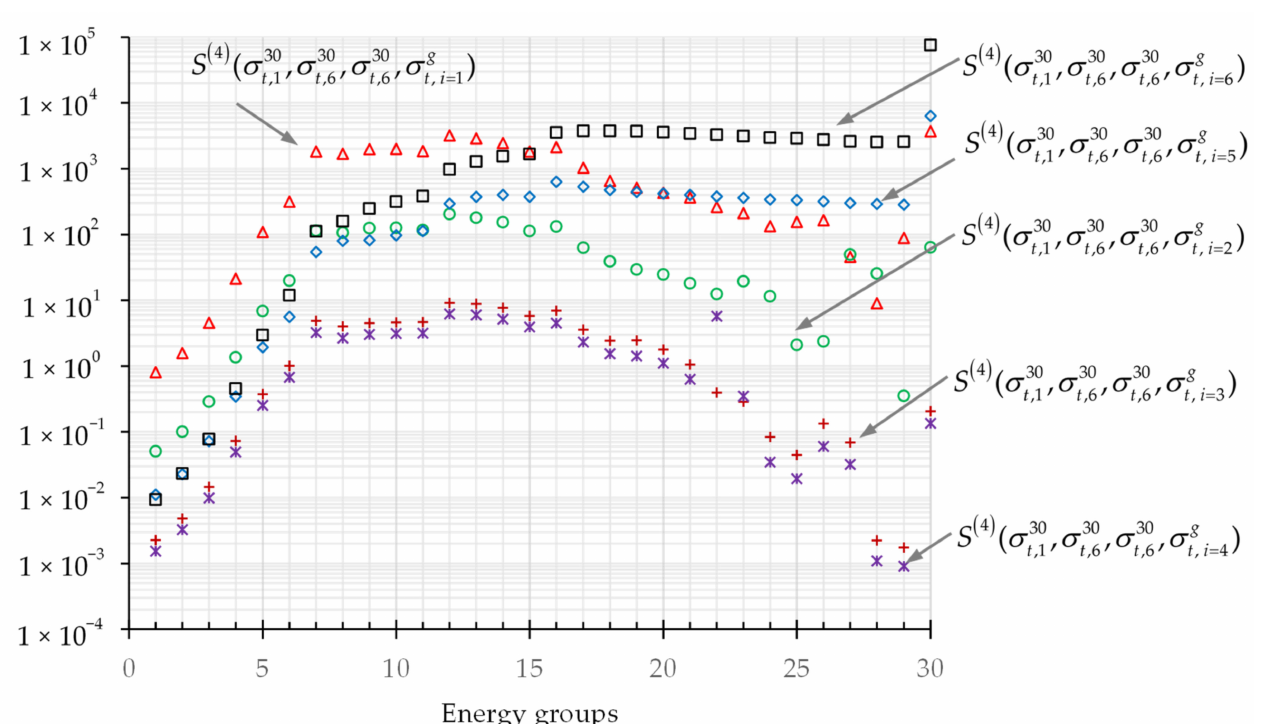
Figure 5. Numerical results for the 4th-order mixed relative sensitivities S ( 4 )